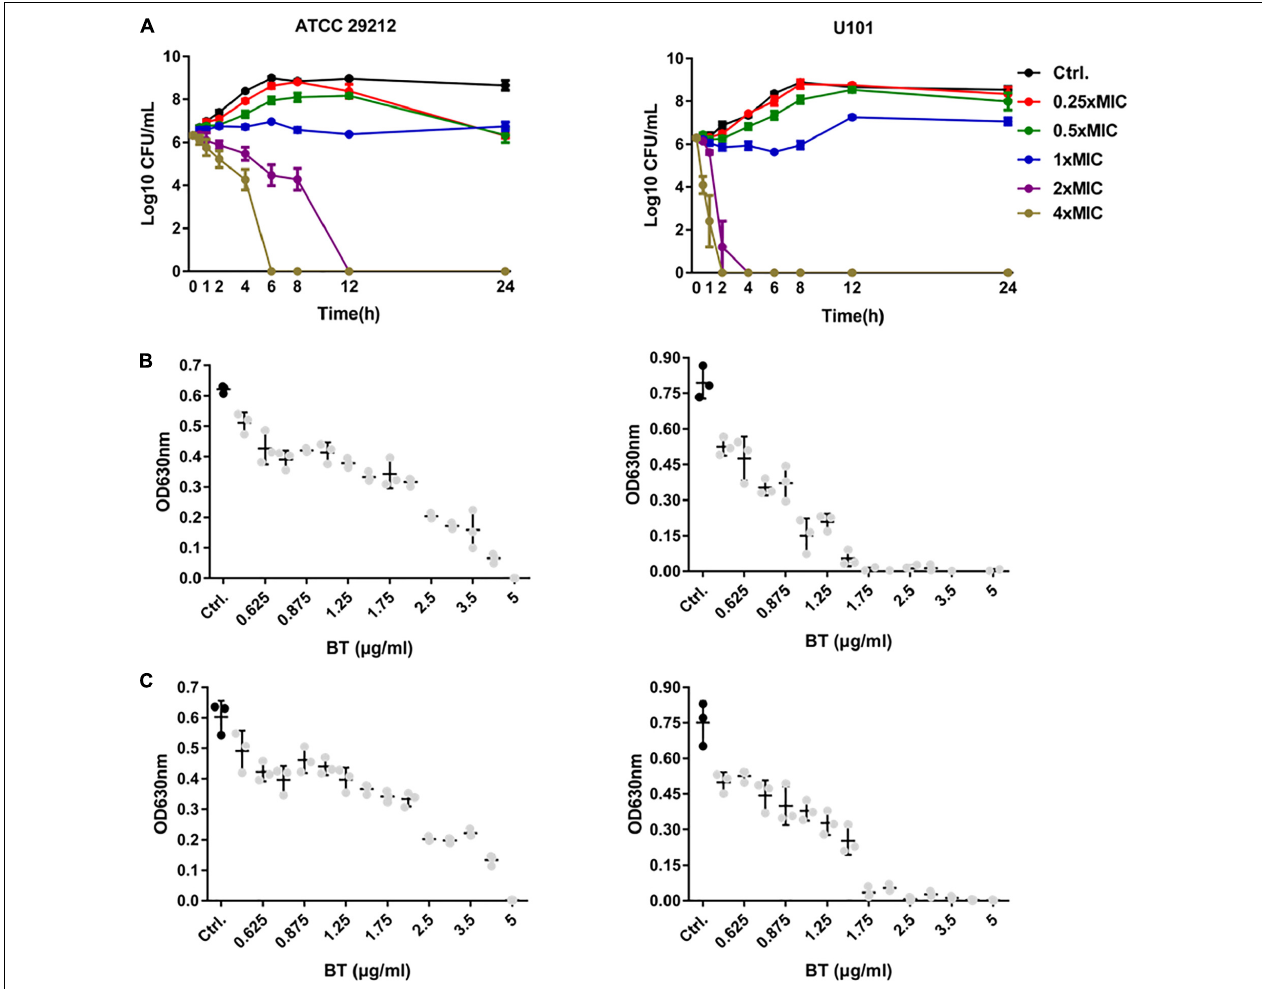
FIGURE 1 | Antimicrobial effects of BT against E. faecalis and E. faecium planktonic cells. (A) Time-dependent antimicrobial effects of BT against ATCC 29212 and U101. Dose-dependent antimicrobial effects of BT against ATCC 29212 and U101 for (B) 16 h and (C) 24 h, respectively. Gray dots indicate p < 0.05, compared with the control